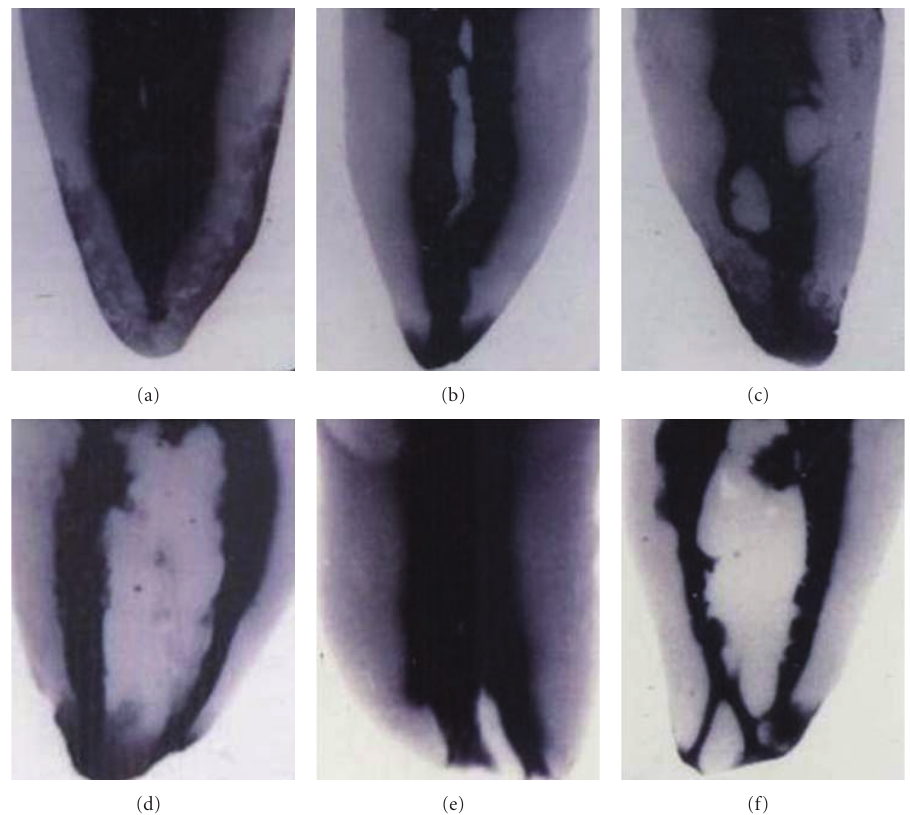
Figure 2: Distal root canal configurations observed in this study. (a) type I, (b) type II, (c) type III, (d) type IV, (e) type V, and (f) apical